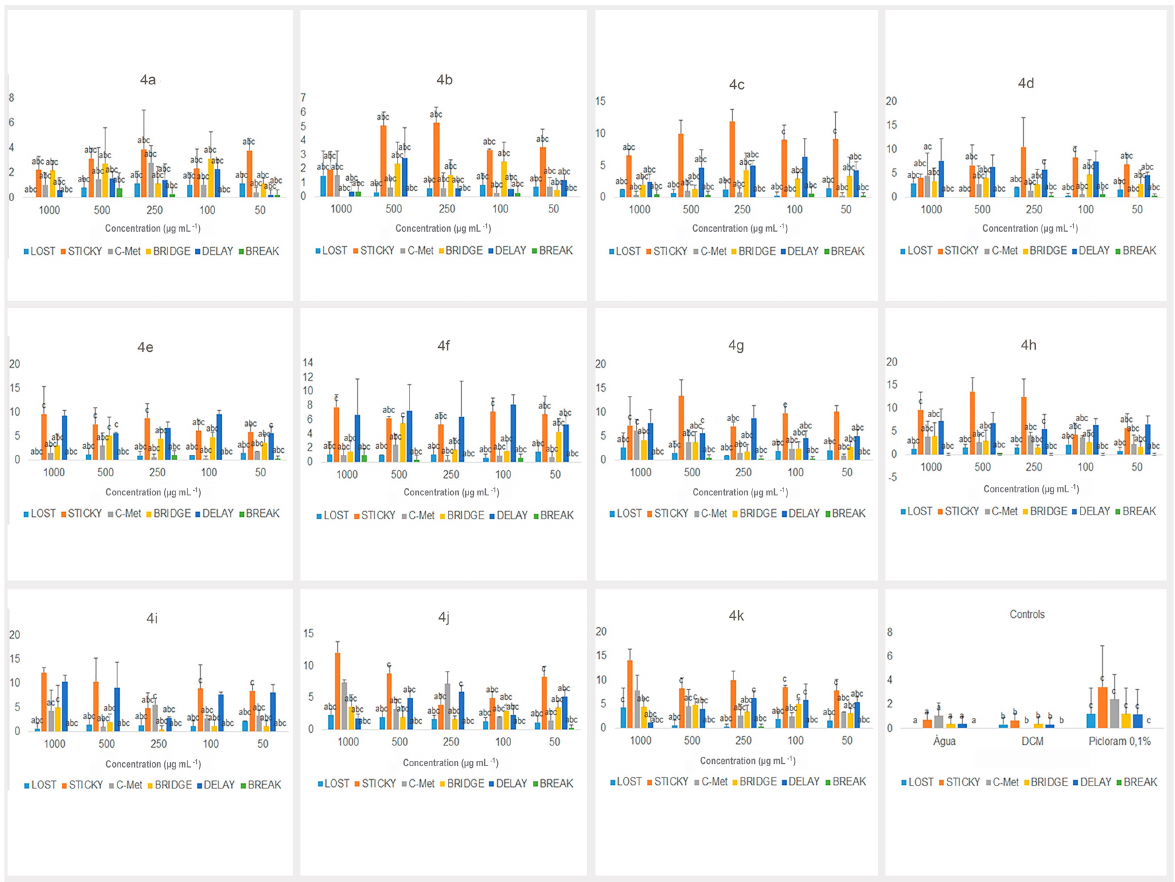
Figure 4. Frequency of chromosomal alterations (Lost, sticky, c-metaphase, bridge, delay and break) observed in Lactuca sativa meristematic cells treated with five concentrations of triazoles 4a to 4k and positive control (picloram) and negative (water and dichloromethane) ( l ). The means followed by the letter a were equal to the negative control water, those followed by the letter b were equal to the negative control dichloromethane and those followed by the letter c were equal to the positive control picloram (0.1%) according to the Dunnett test ( p